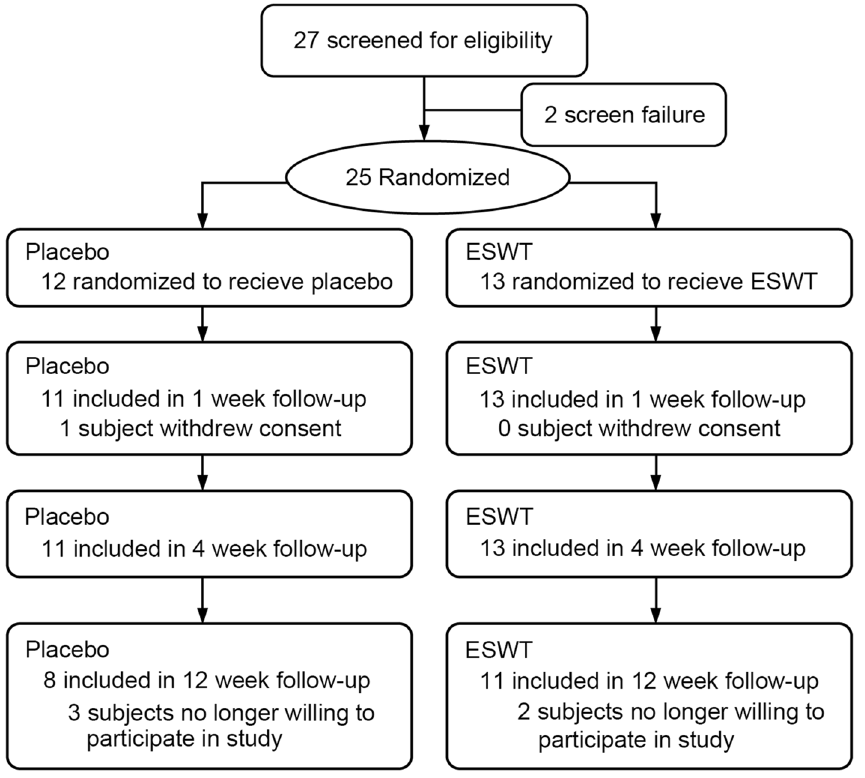
Figure 1. Patient allocation and flow chart of the study.